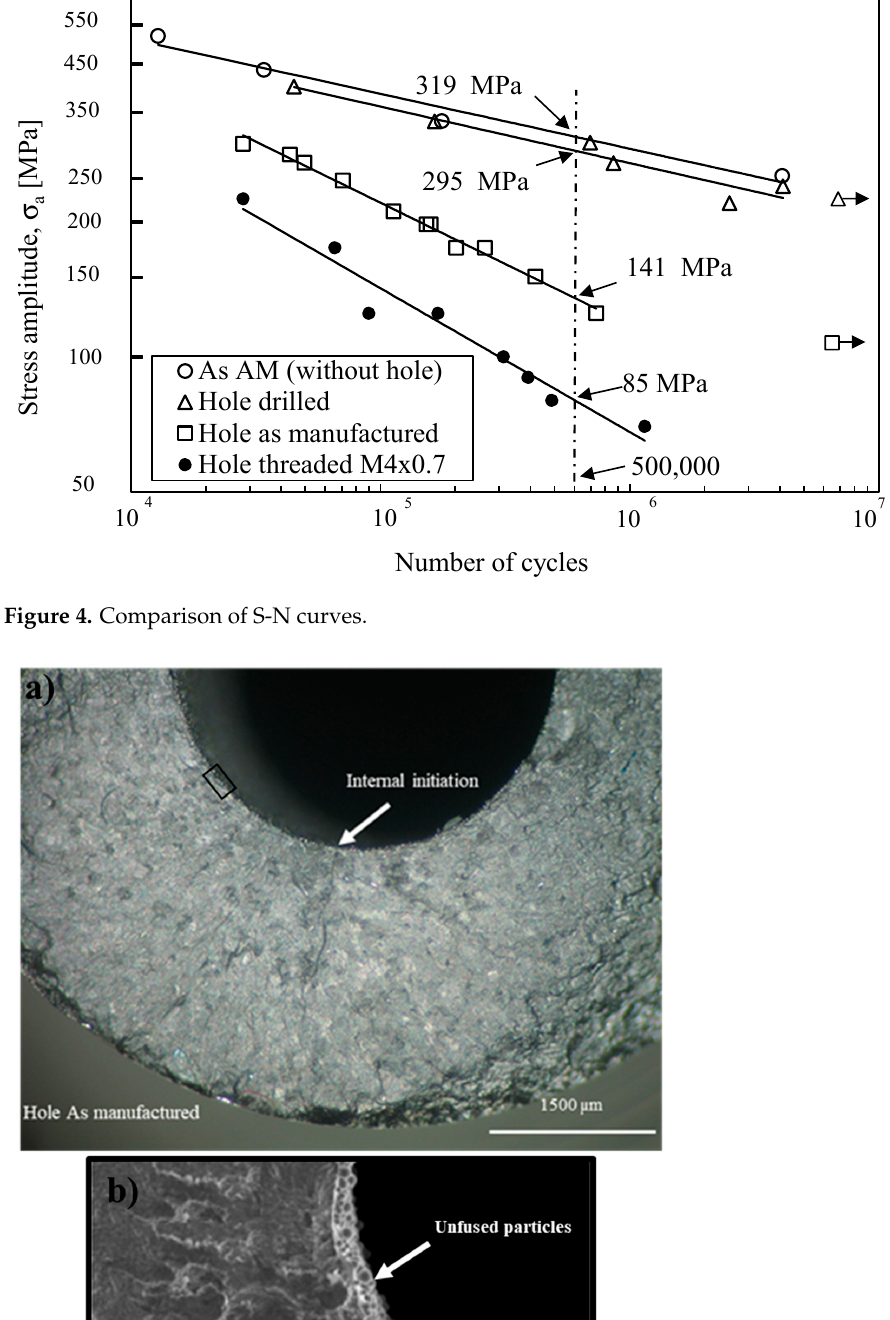
Figure 6. Fracture surface of hole threaded, σ a = 80 MPa.